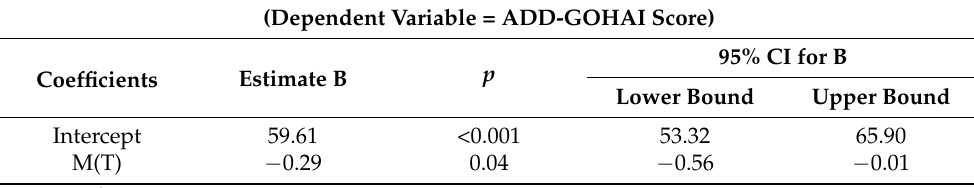
Table 4. Linear regression model to predict centenarians’